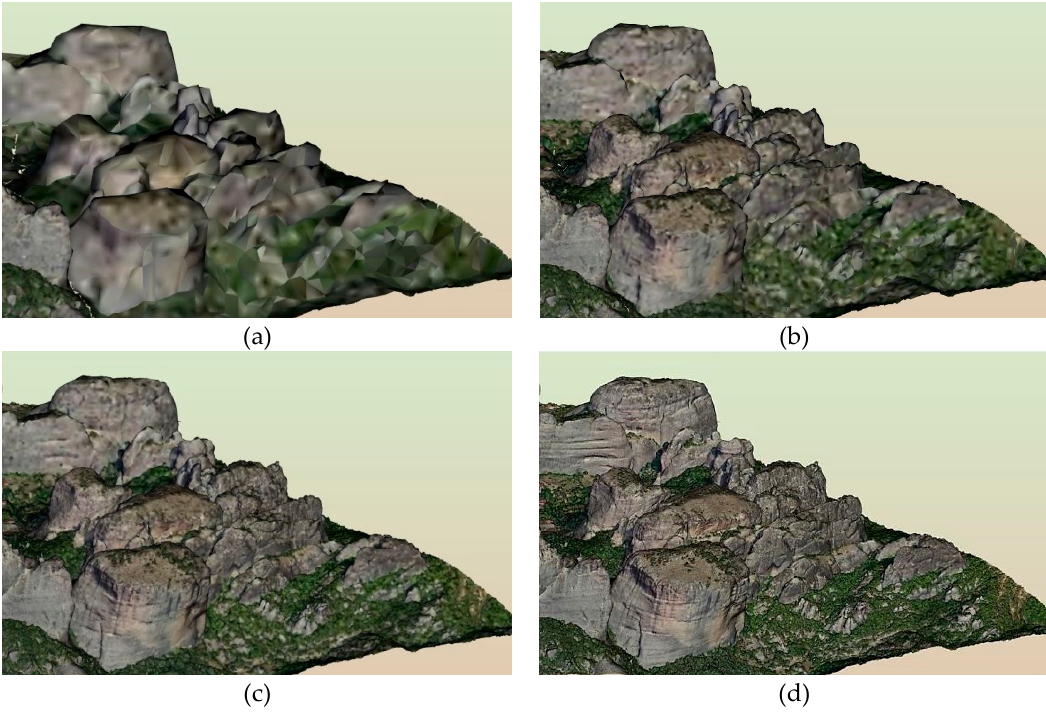
Figure 16. Visualization results of a detail of the 3D model of Meteora after ( a ) 0.5 s, ( b ) 1 s, ( c ) 1.5 s and ( d ) 2 s from homepage launch.